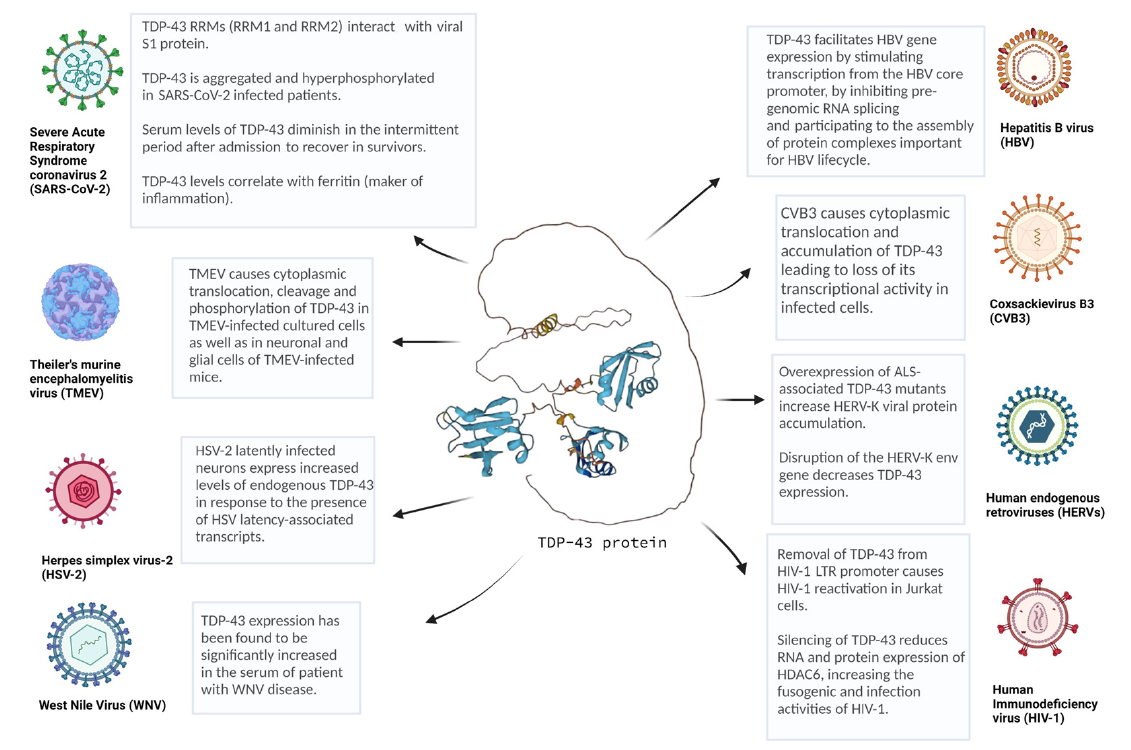
Figure 2. Overview of several viruses linked to TDP ‐ 43 proteinopathy. TDP ‐ 43 is involved in several infections by DNA and RNA viruses, including Coxsackievirus B3 (CVB3), Theiler’s murine enceph ‐ alomyelitis virus (TMEV), human immunodeficiency virus (HIV), human endogenous retroviruses (HERVs), hepatitis B virus (HBV), severe acute respiratory syndrome coronavirus 2 (SARS ‐ CoV ‐ 2), West Nile virus (WNV), and herpes simplex virus ‐ 2 (HSV). This picture was created with Bioren ‐ der.com. Predicted TDP ‐ 43 ternary ‐ structure was created using AlphaFold algorithm and reprinted with the permission from Refs. [153,154]. Table 1. List of TDP ‐ 43 related viruses and brain involvement.